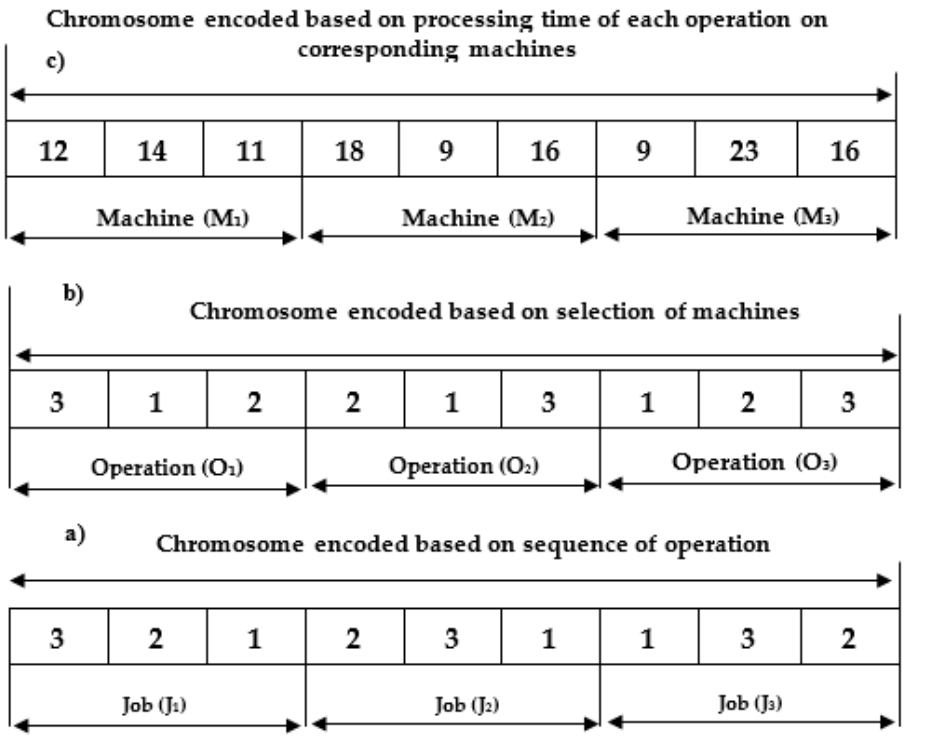
Figure 8. Representation of chromosome initialization for make span.